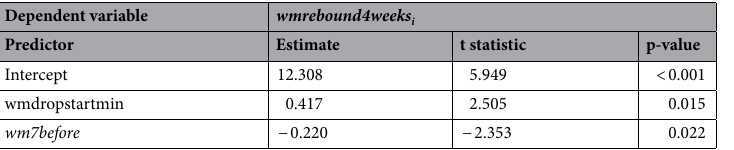
Table 3. Estimation results for a linear model of the mobility rebound as a function of country characteristics. R 2 : 0.148, Adjusted R 2 : 0.118; F-statistic: 4.86 on 2 and 56 degrees of freedom (n =